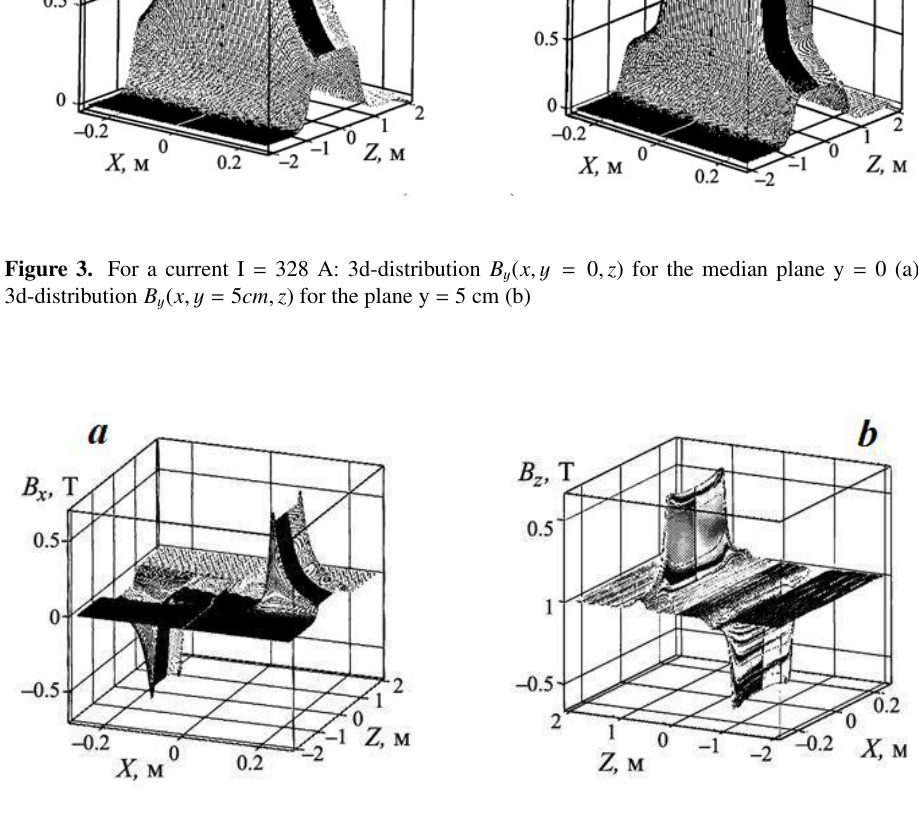
Figure 4. For a current I = 328 A: 3d-distribution B x ( x ,y = 5 cm , z ) for the plane y = 5 cm (a); and 3d-distribution B z ( x ,y = 5 cm , z ) for the the plane y = 5 cm